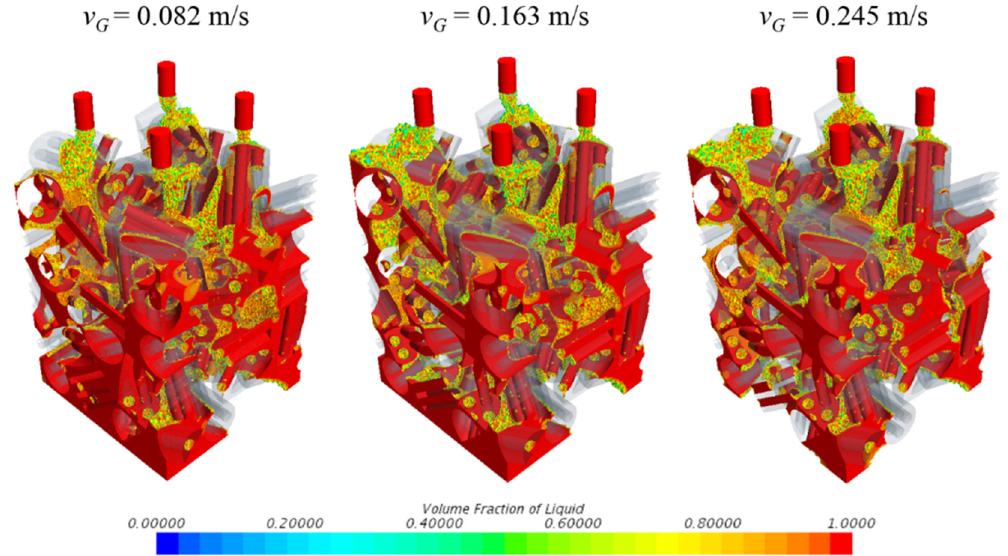
Figure 10. Liquid distributions with di ff erent gas superficial velocities ( v L = 0.008 m/s).